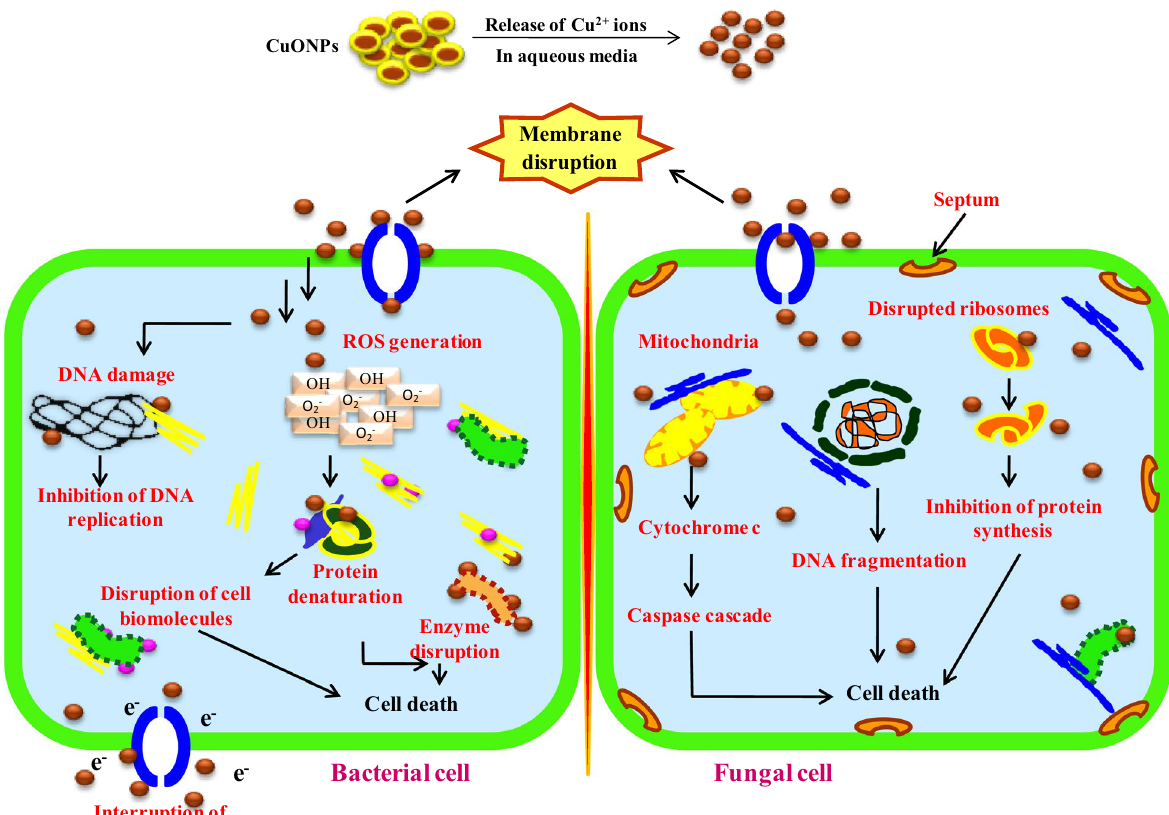
Figure 5. The proposed antimicrobial mechanisms induced by CuONPs for inhibition in bacterial and fungal